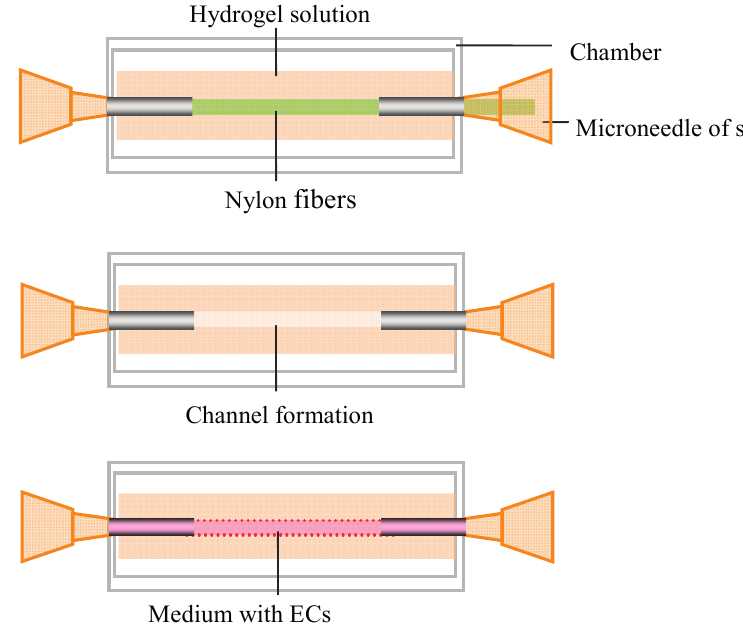
Figure 2. Molding approach for fabrication of microfluidic constructs. Microneedles and a Nylon fiber are fixed inside a chamber. Then hydrogel solutions are poured into the chamber and gelled. Then open channels are formed by gently removing the